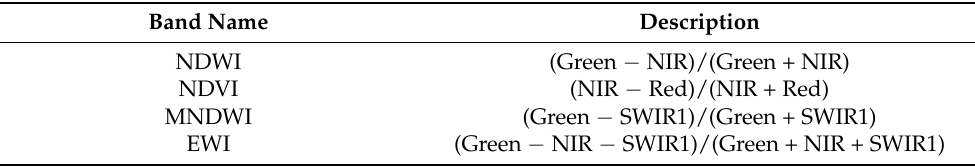
Figure 2. The results of the features calculated from Sentinel-2 data: ( a ) NDWI, ( b ) NDVI, ( c ) MNDWI, ( d ) EWI. Table 3. Detailed descriptions of the features extracted from Sentinel-2